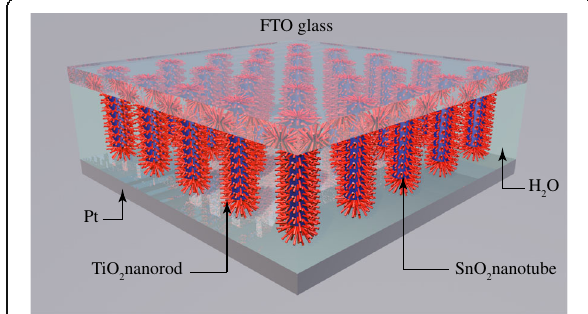
Fig. 1 The schematic structure of the nanostructured SnO 2 -TiO 2 /H 2 O solid-liquid heterojunction-based UV